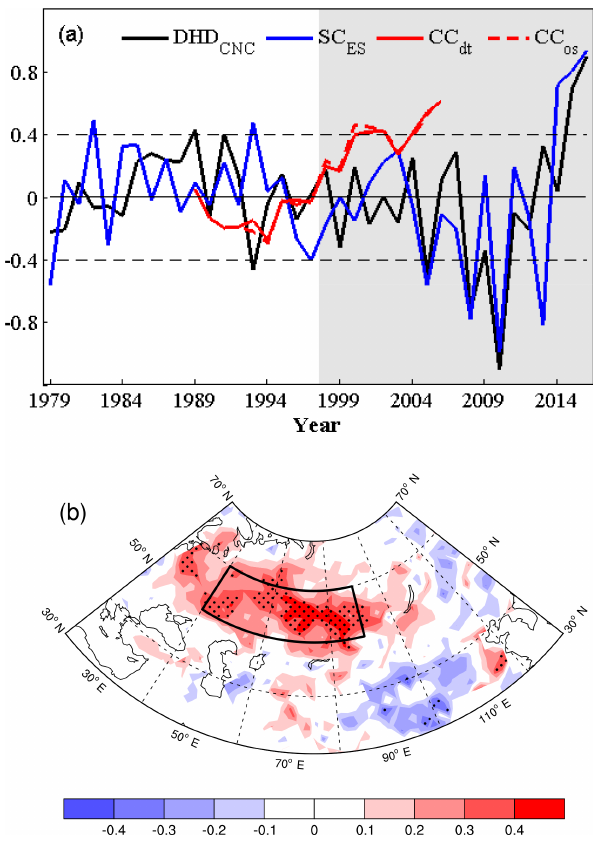
Figure 1. (a) The variation in the normalized DHD CNC (black) and SC ES (blue) from 1979 to 2016 after detrending and the 21- year running correlation coefficient (CC) between the DHD NH and SC ES before (solid, red) and after (dashed, red) detrending. (b) The CC between the DHD CNC and snow cover from 1979 to 2016 after detrending. The black dots indicate CCs exceeding the 95% con- fidence level ( t test). The black box represents the ES area. The subscripts “dt” and “OS” in panel (a) indicate that the CC was cal- culated by the detrending and original sequence.